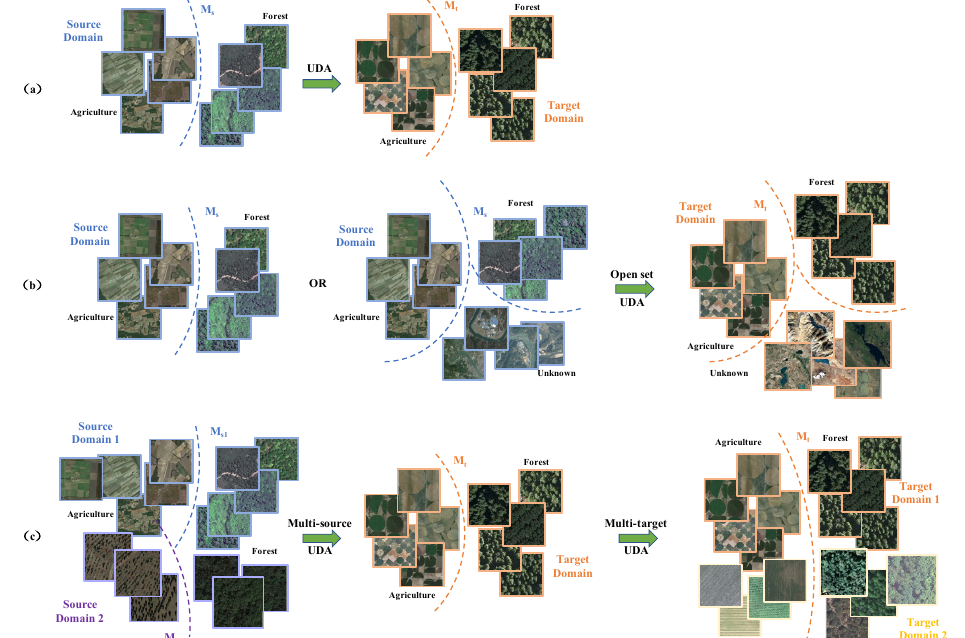
Figure 1. Visualization samples of different definition and setting of unsupervised domain adaptation based on AID, NWPU and PatternNet datasets. ( a ) Standard unsupervised domain adaptation of a single-source and target domain, which share the same label space. ( b ) Open-set unsupervised domain adaptation with two different settings, where unknown instances are seen in the source domain and unknown classes that are not the same between two domains and another are un- seen. ( c ) Multi-domain unsupervised domain adaptation divided into multi-source or multi-target domain